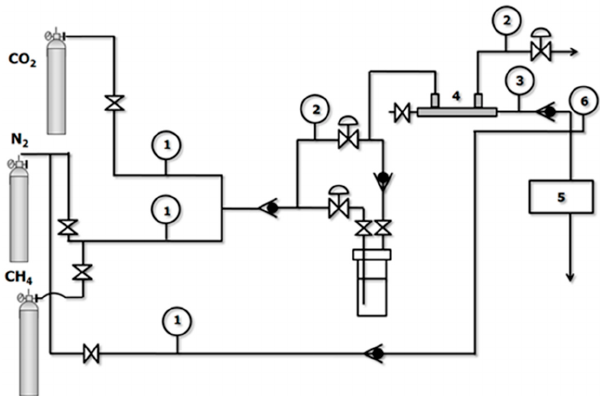
Figure 1. Experimental setup. (1) Mass flow meters, (2) pressure regulators, (3) pressure gauges, (4) HF membrane module, (5) analyzer, (6) bubble flowmeter.